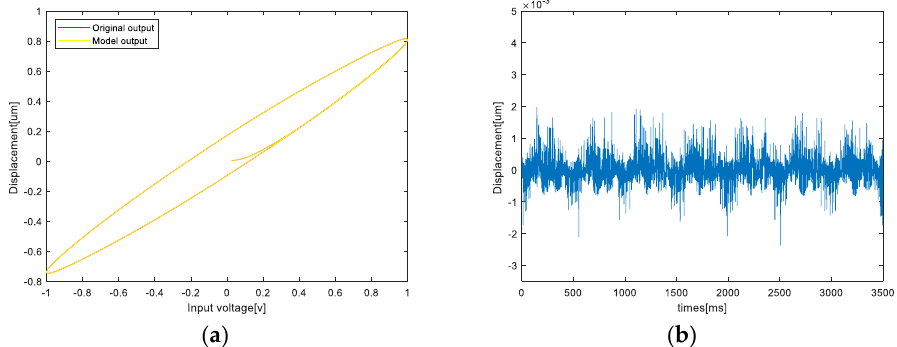
Figure 7. When the input frequency f = 20 Hz: ( a ) hysteresis model; ( b ) modeling error.